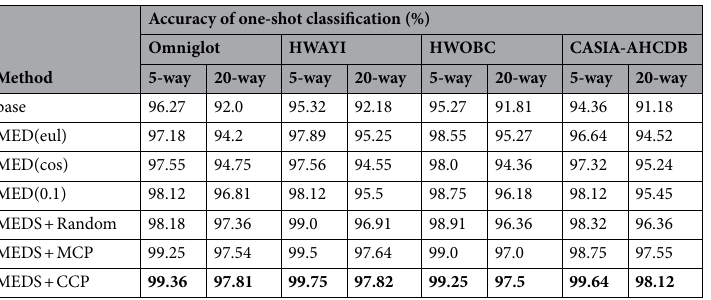
Table 3. One-shot classification performance of our method on three datasets, the best-performing method is highlighted. “MED” indicates integration of MSB, EB and D in the Fig. 2. “MEDS” indicates integration of MSB, EB, D and SSCL. Significant values are in